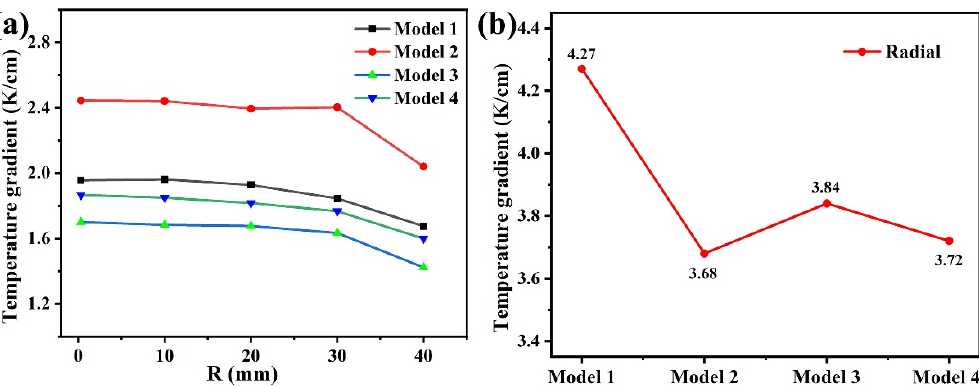
Figure 3. ( a ) The temperature gradient change in the Z direction at different positions along the R direction in different heating modes. ( b ) Radial temperature gradient change under different heating modes.